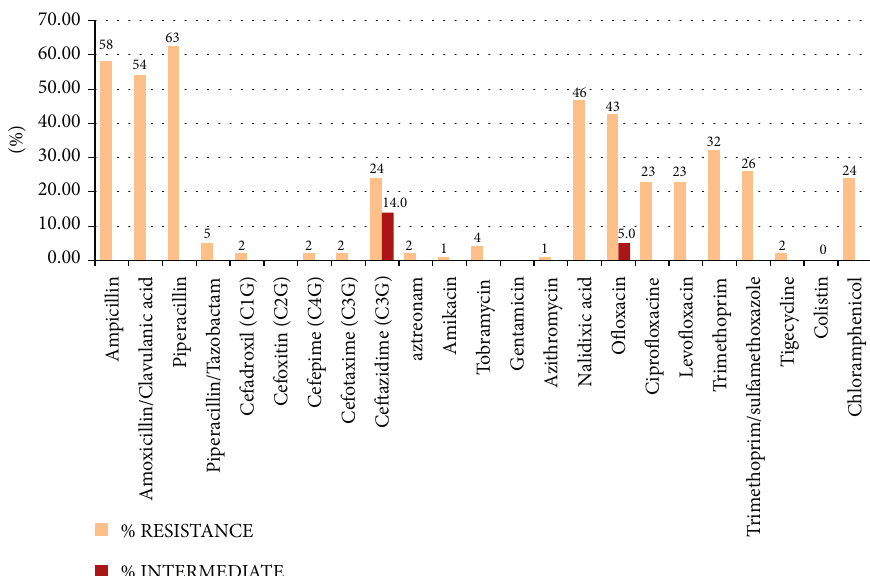
Figure 1: Pro fi le of the antimicrobial resistance in the 96 E. coli isolates.